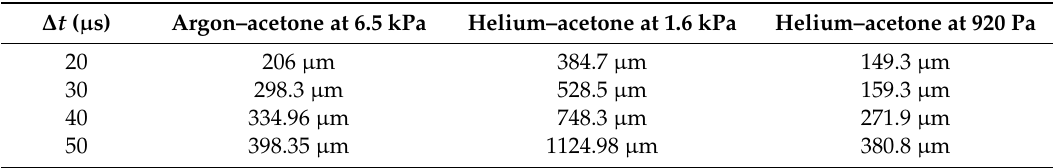
Table 5. Thickness ∆ s x of the displacement profile related to the data of argon–acetone flow at 6 kPa (Figure 16a) and of helium–acetone flows at 1.6 kPa (Figure 18a) and at 920 Pa (Figure 18b). ∆ t ( µ s)